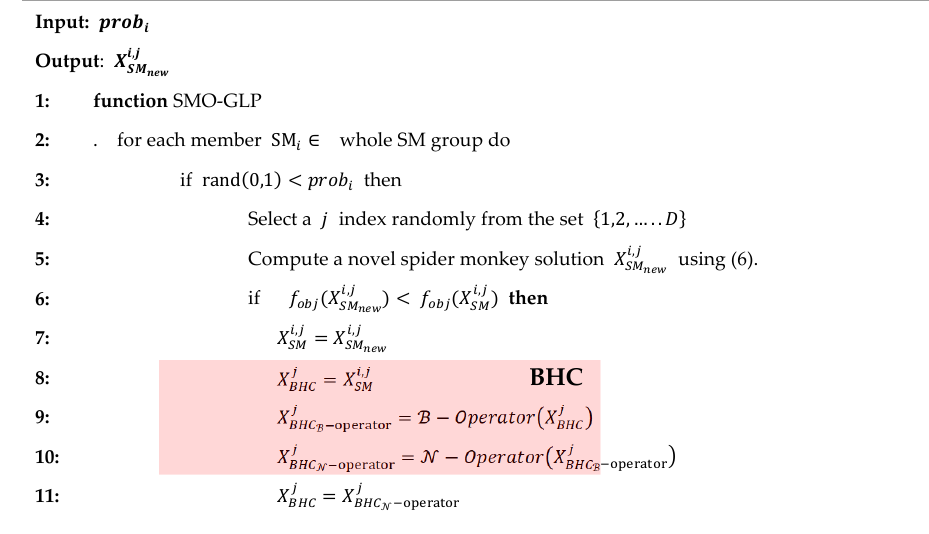
Algorithm 6 : Global Leader Phase (GLP) based on BHC